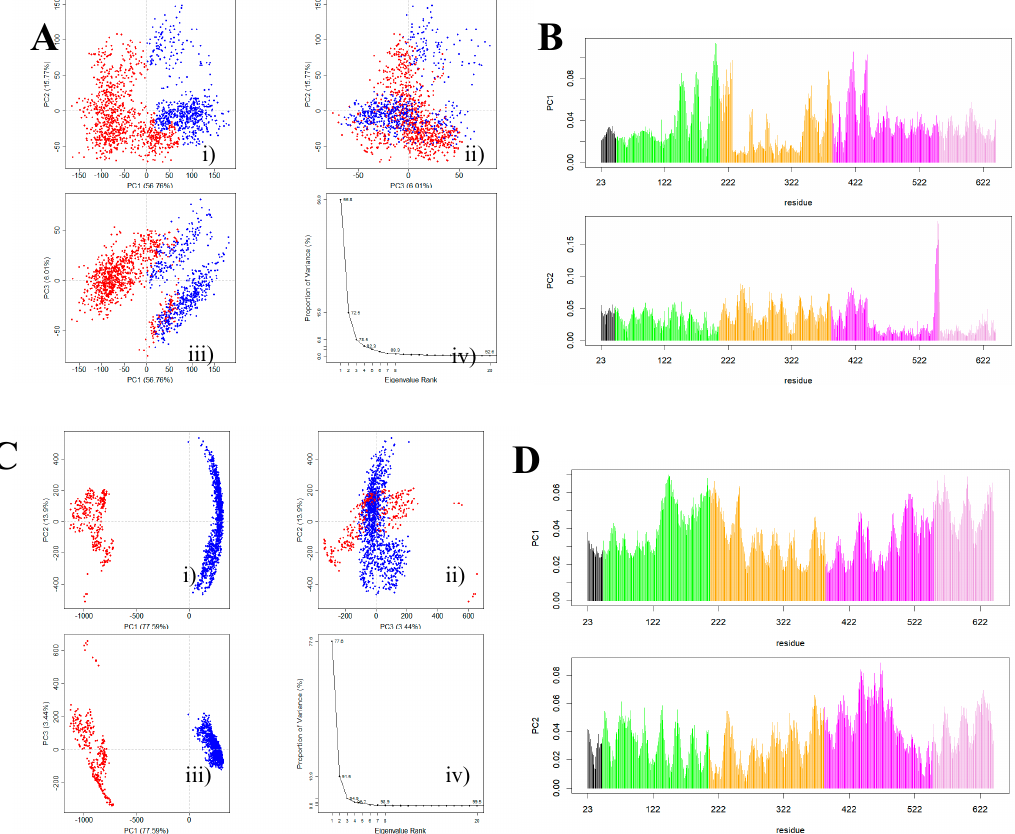
Figure 5. Principal components analysis (PCA) clustering results of the MD simulation trajectories of the complexes. i) Principal components (PC) 1 and 2; ii) PC2 and PC3; iii) PC3 and PC1; iv) percentage